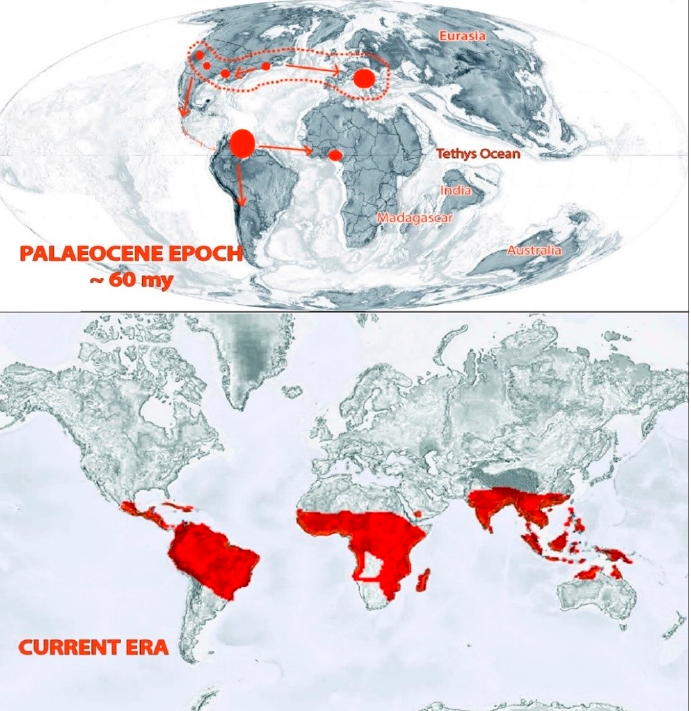
Figure 3. Distribution of Bombacoideae in past and present eras. Adapted from Krutzsch, [20], Zizka et.al. [11], and Angiosperm Phylogeny website version 14 (www.mobot.org/MOBOT/ research/APweb; accessed on 10 January